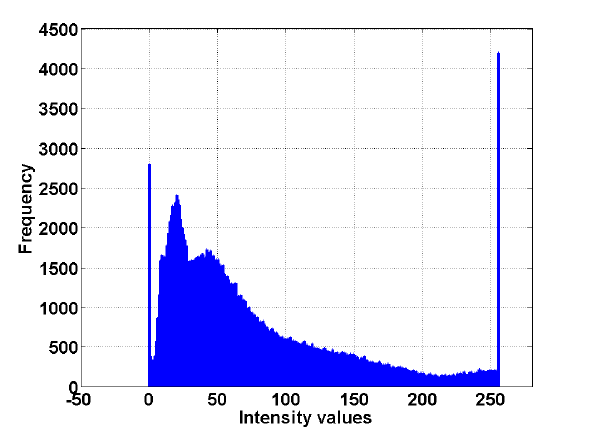
Figure 5. Histogram of the intensity values of the DTM points.